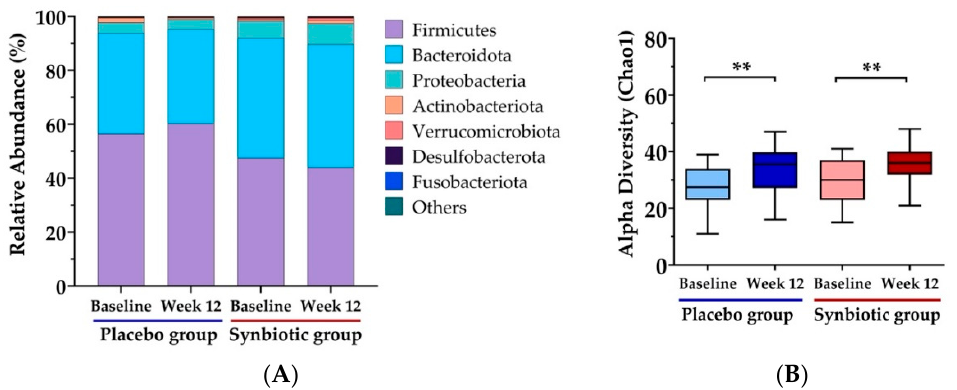
Figure 2. E ff ect of 12-week synbiotic intervention on gut microbiota composition in overweight and obese subjects. ( A ) Bar graphs show the phylum-level inter-individual variability in fecal microbiota. ( B ) The box plot shows the interquartile range, maximum value, and minimum value for the alpha diversity index: Chao1, which measures community richness. Values are represented as mean ± SD. ** p < 0.01 compared to baseline.